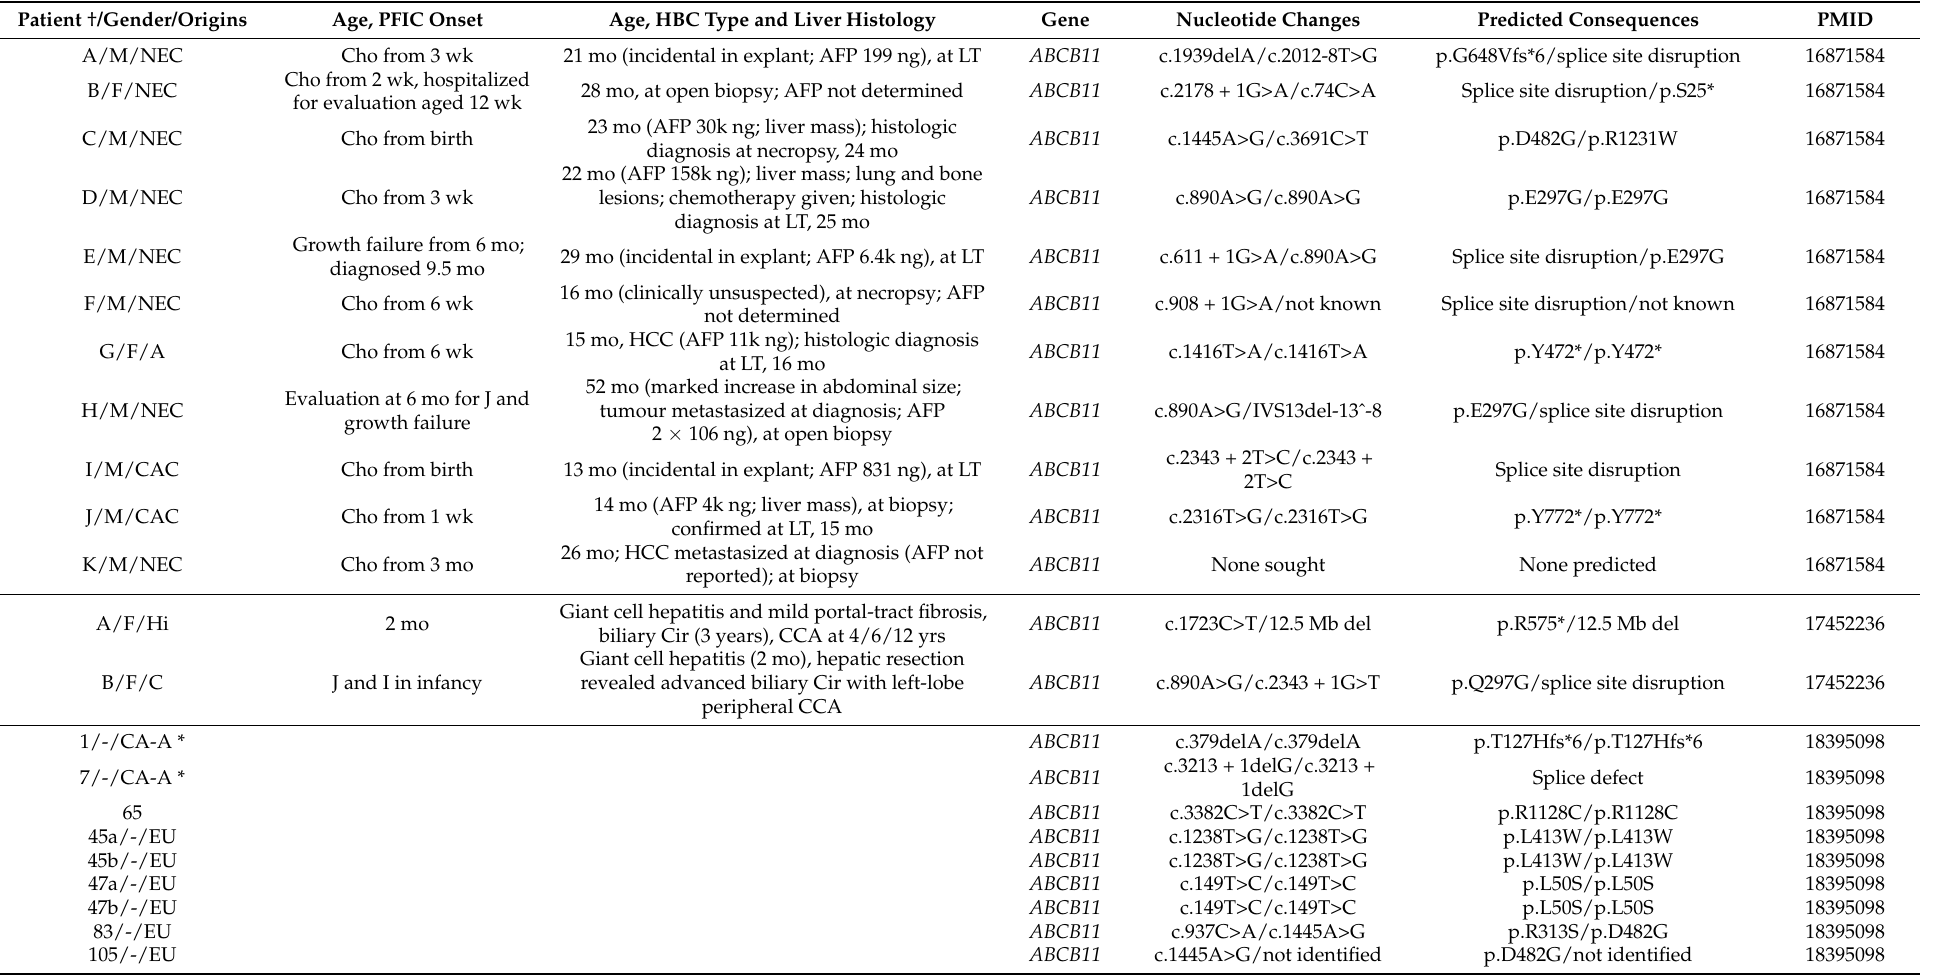
Table 2. Cases described in PubMed of HBCs associated with mutations in cholestasis-related